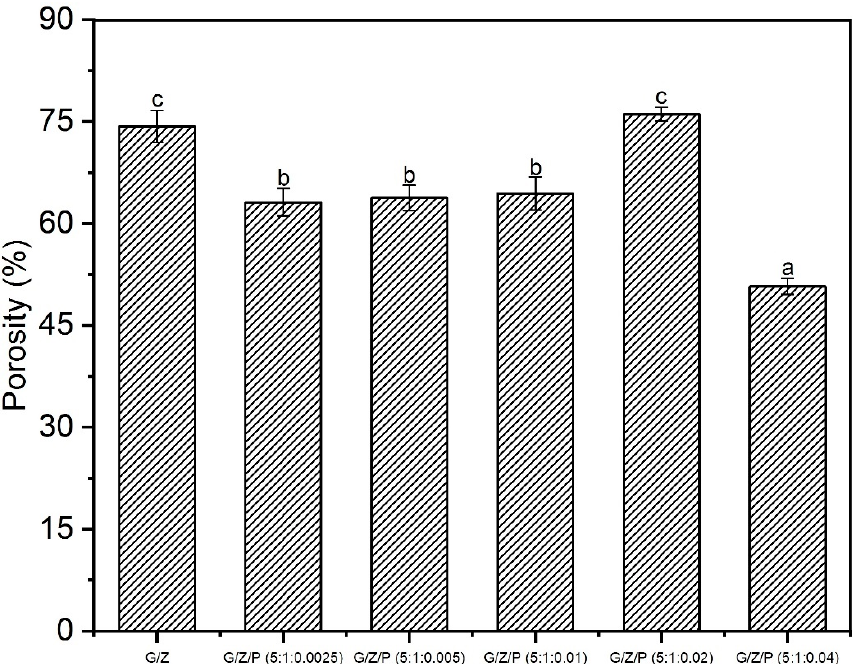
Figure 3. The porosity of the gelatin/zein/perillaldehyde nanofiber films. The values are given as the mean ± SD, and different letters in the same line mean the significant difference ( p < 0.05).